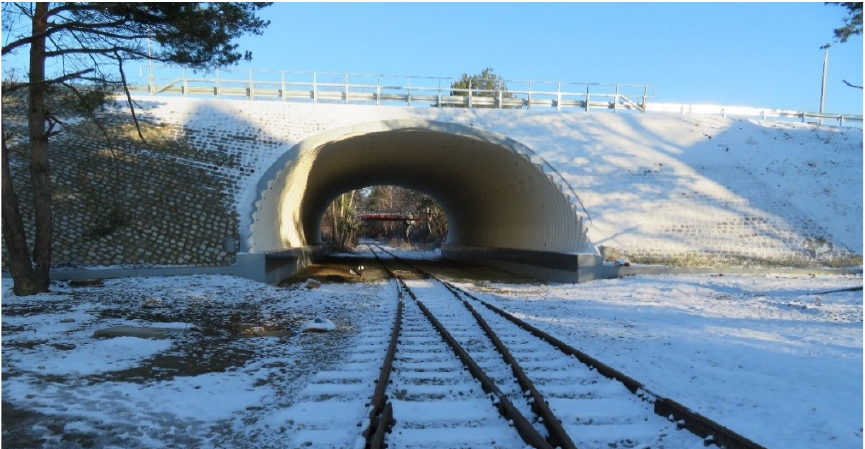
Figure 1. Example of soil–steel composite bridge located in Opole (Poland).